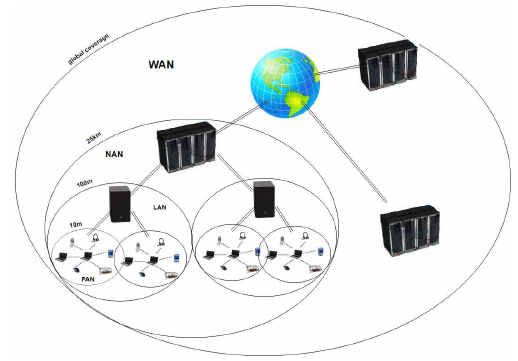
Figure 1. A network range of IoT